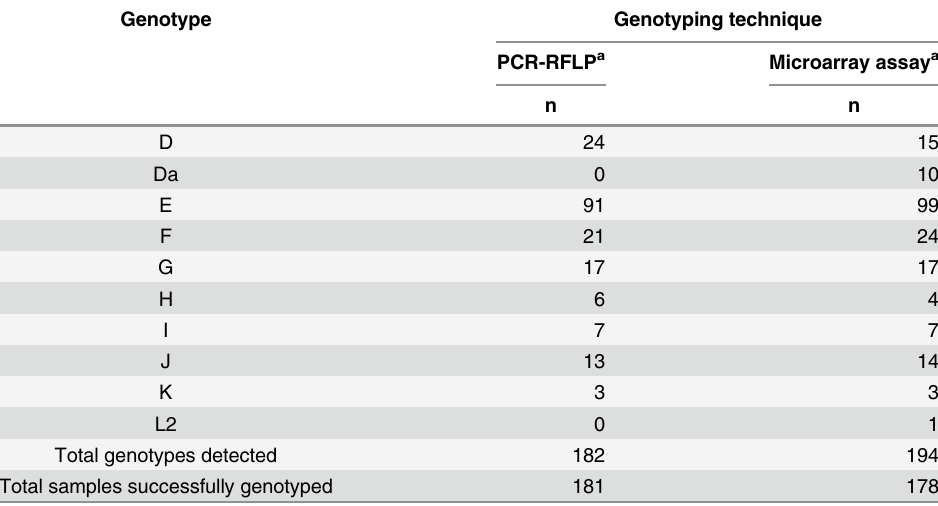
Table 2. C . trachomatis genotype distribution according to genotyping